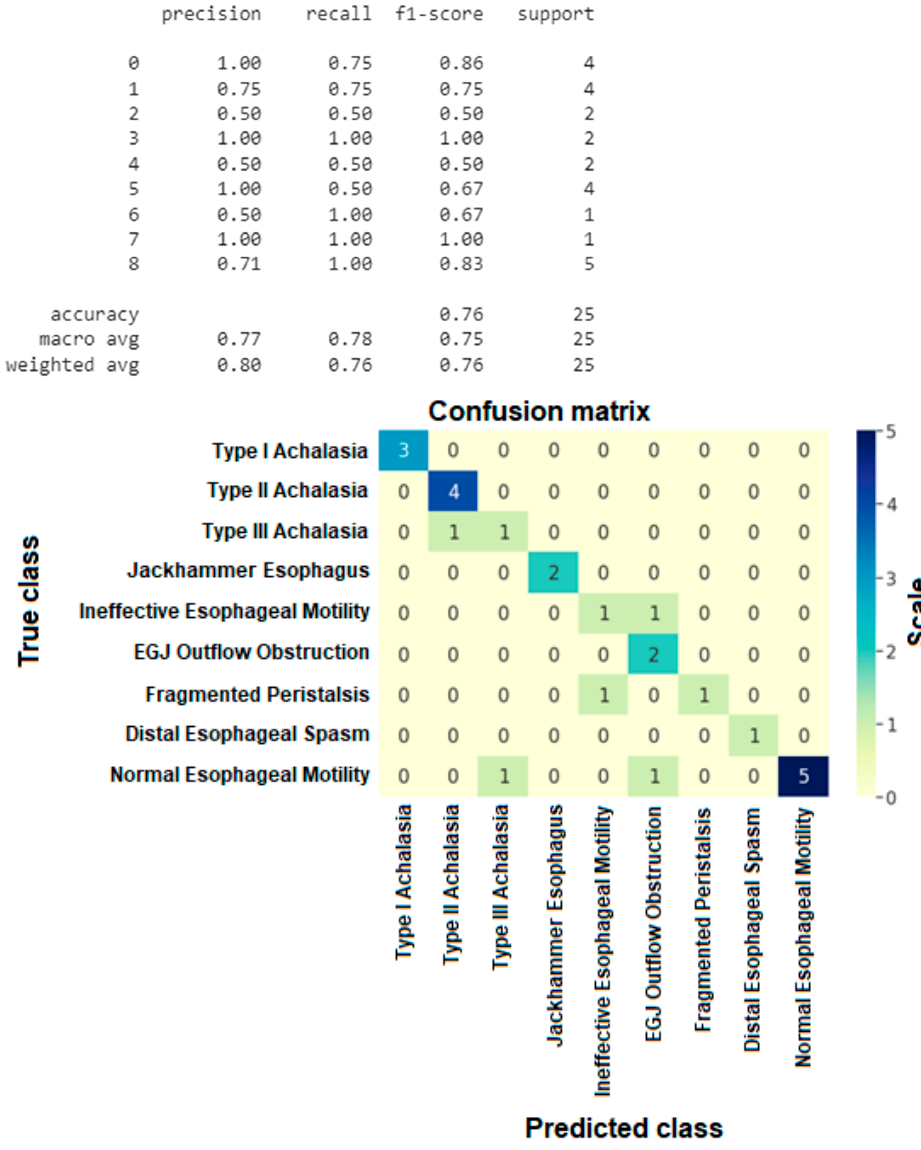
Figure 7. Esophageal motility disorders confusion matrix.